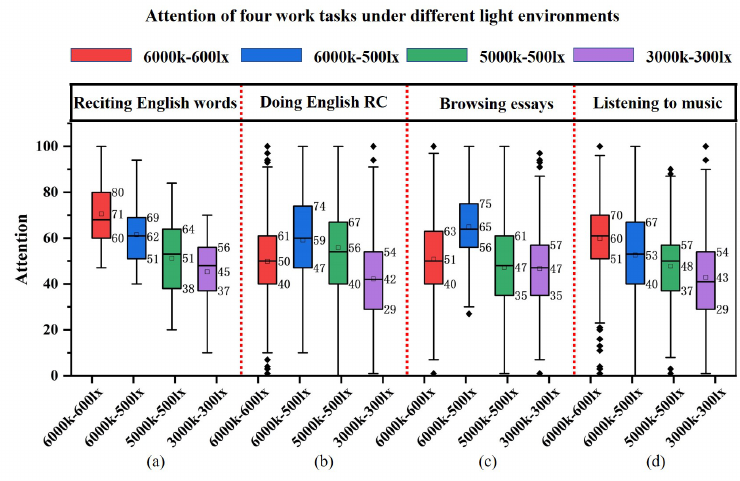
Figure 20. Box plot: attention of four work tasks in different light environments, including ( a ) reciting words, ( b ) doing reading comprehension, ( c ) browsing essays, and ( d ) listening to